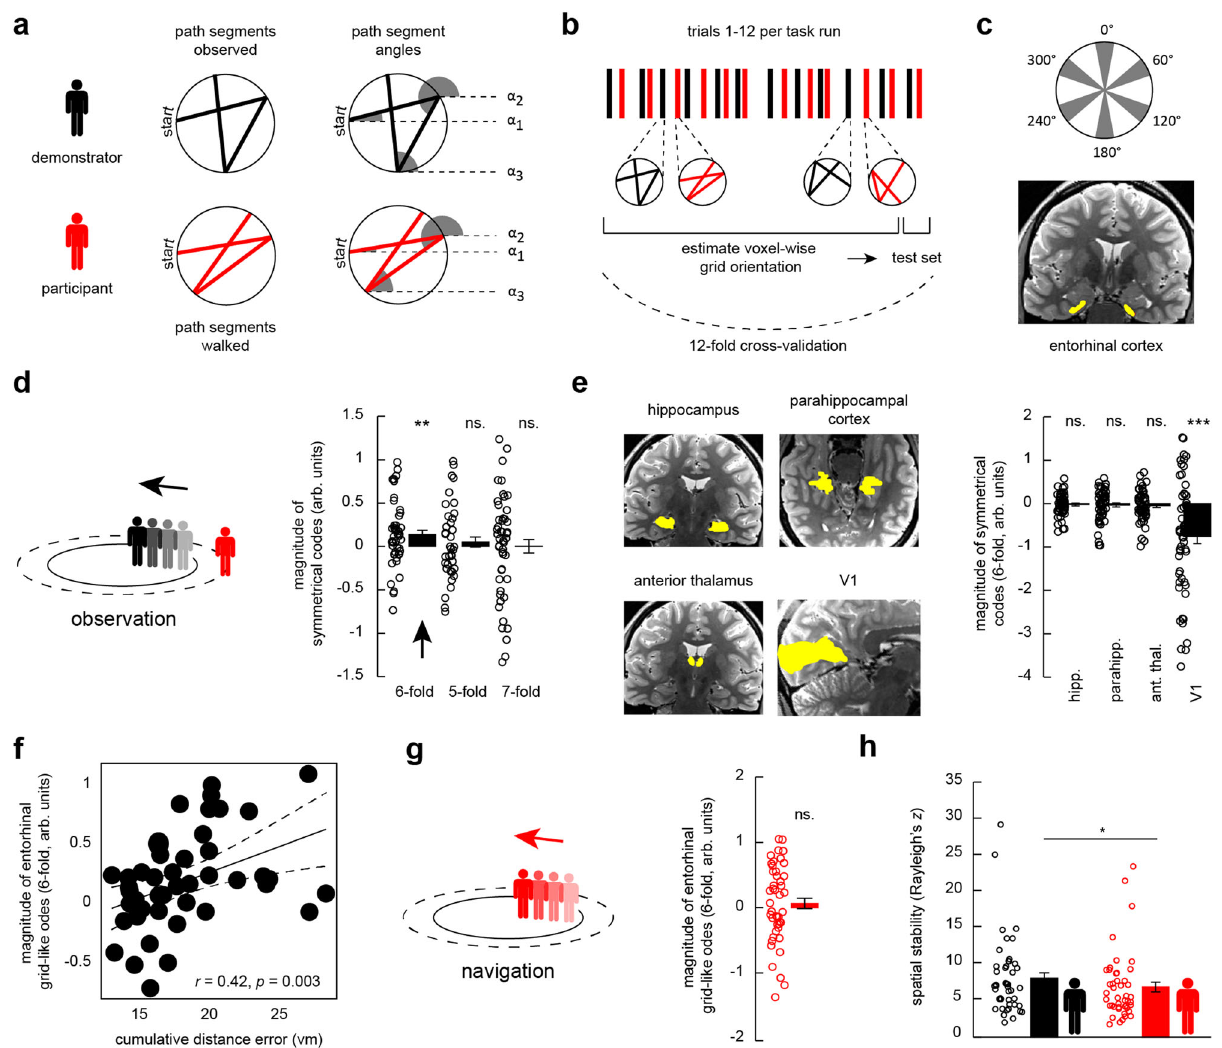
Fig. 3 | Grid-like codes during observation. a We calculated path-wise trajectory angles α 1 – α 3 referenced to anarbitrarypoint on the VRdesert plane (dashed lines, angles indicated in gray). b Schematic of the trial composition within a task run, showing observation (black) and navigation (red) periods that consisted of three pathsegmentseach(1trial=1observationperiodfollowedby1navigationperiod). Gridorientationswereestimatedandtestedbyemployinga12-foldcross-validation (CV) regime. c Schematic of angular differences in 360°-VR-space. We expected increased entorhinal cortex signal for directions observed/walked that were alignedtoindividualgridorientations(ingray).Entorhinalcortexregion-of-interest (ROI, in yellow) projected onto the T2-weighted structural scan of one participant. d Magnitude of symmetrical codes (separate one-sample t -tests, one-tailed, mul- tiple comparisons corrected; 6-fold: N =47, p =0.005; 5-fold: N =42, p =0.245; 7- fold: N =48, p =0.489) in the entorhinal cortex during observation periods